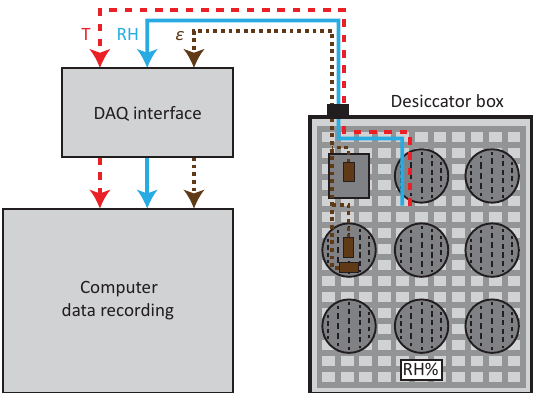
Figure 3. Schematic illustration of the experimental setup of the stepwise cyclic RH laboratory